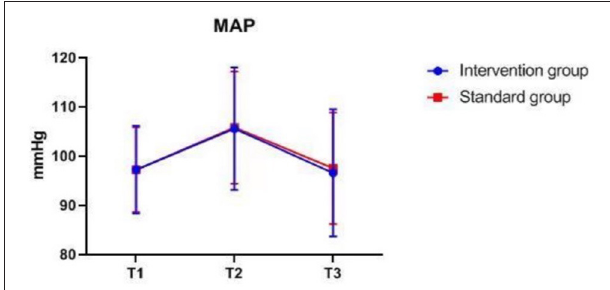
FIGURE 4 | Ipsilateral rSO 2 over time. rSO 2 , regional cerebral oxygenation. The measurement time interval after general anesthesia but before clamping the carotid artery was recorded as baseline reference T1, the time interval after clamping but before declamping was recorded as T2, and the time interval after the declamping and stabilization of cerebral perfusion but before completion of surgery was recorded as T3.